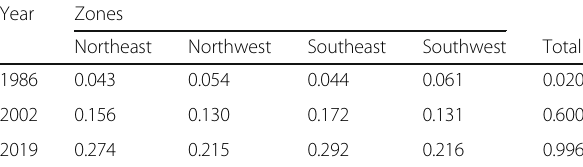
Table 4 Zone-wise entropy values in 1986, 2002 and